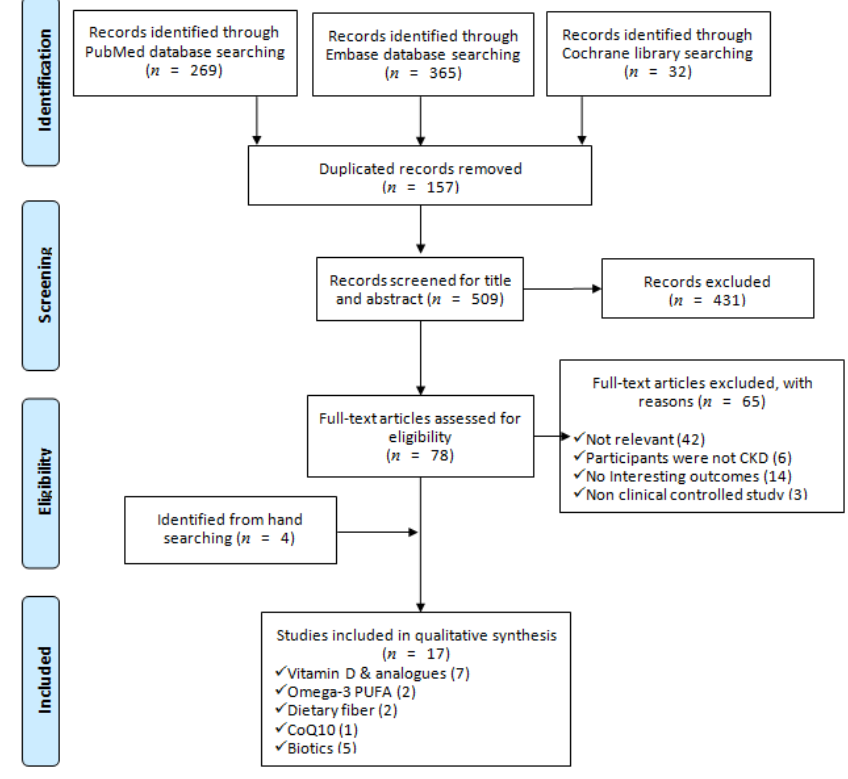
Figure 1. PRISMA flow diagram of including systematic reviews in this study [28].